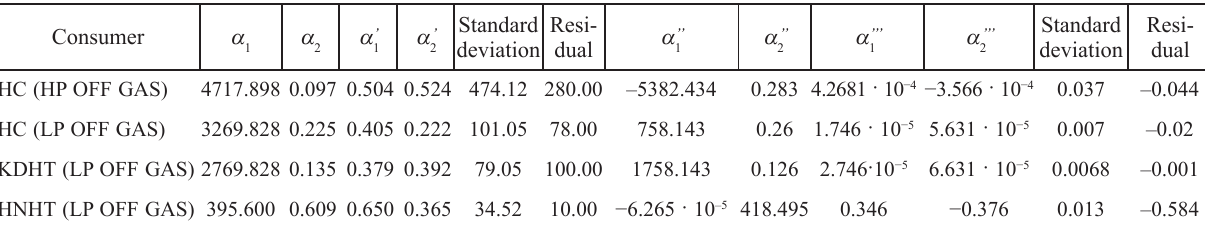
Table 5 – Data for model parameters